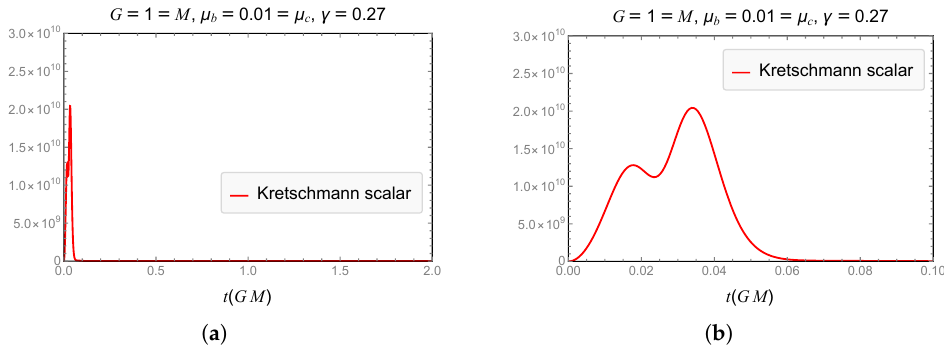
Figure 6. K in the ˚ µ case. ( a ) The Kretschmann scalar K for the ˚ µ case as a function of the Schwarzschild time t . ( b ) Close up of K close to t = 0. It is seen that K remains finite everywhere in the interior and vanishes for t =